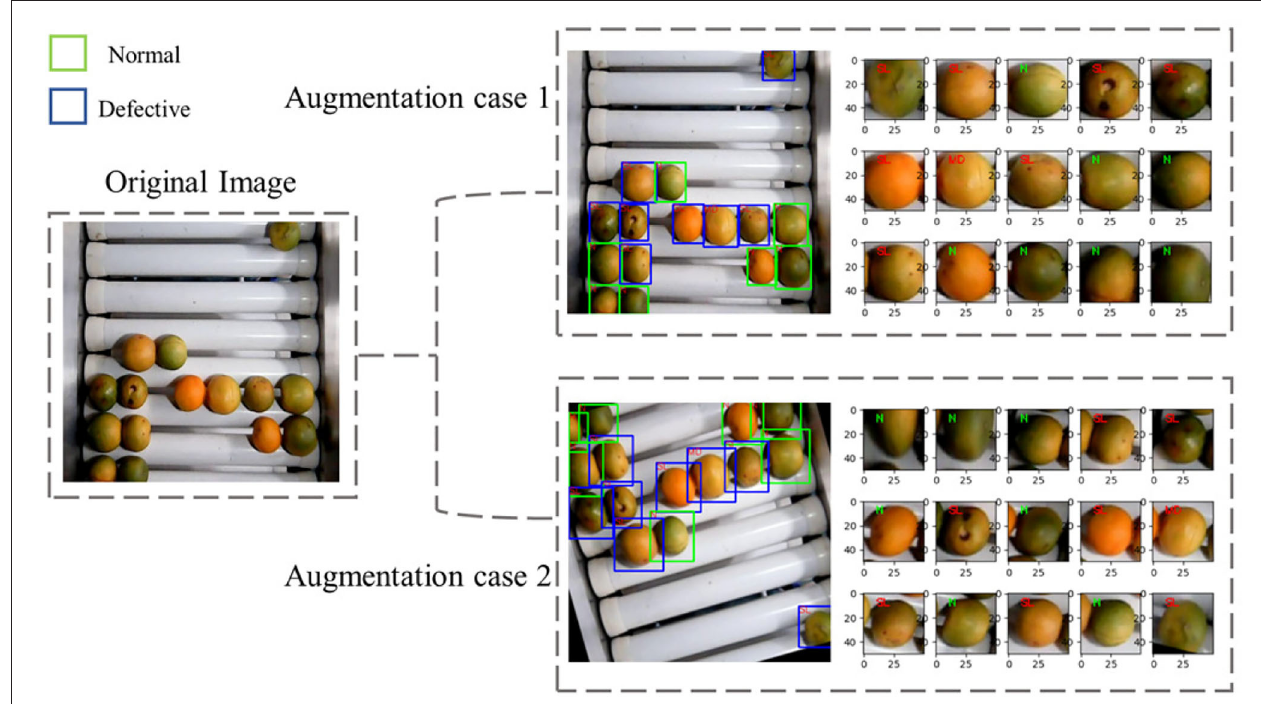
FIGURE 5 | The example of augmented images and labels in network model training.